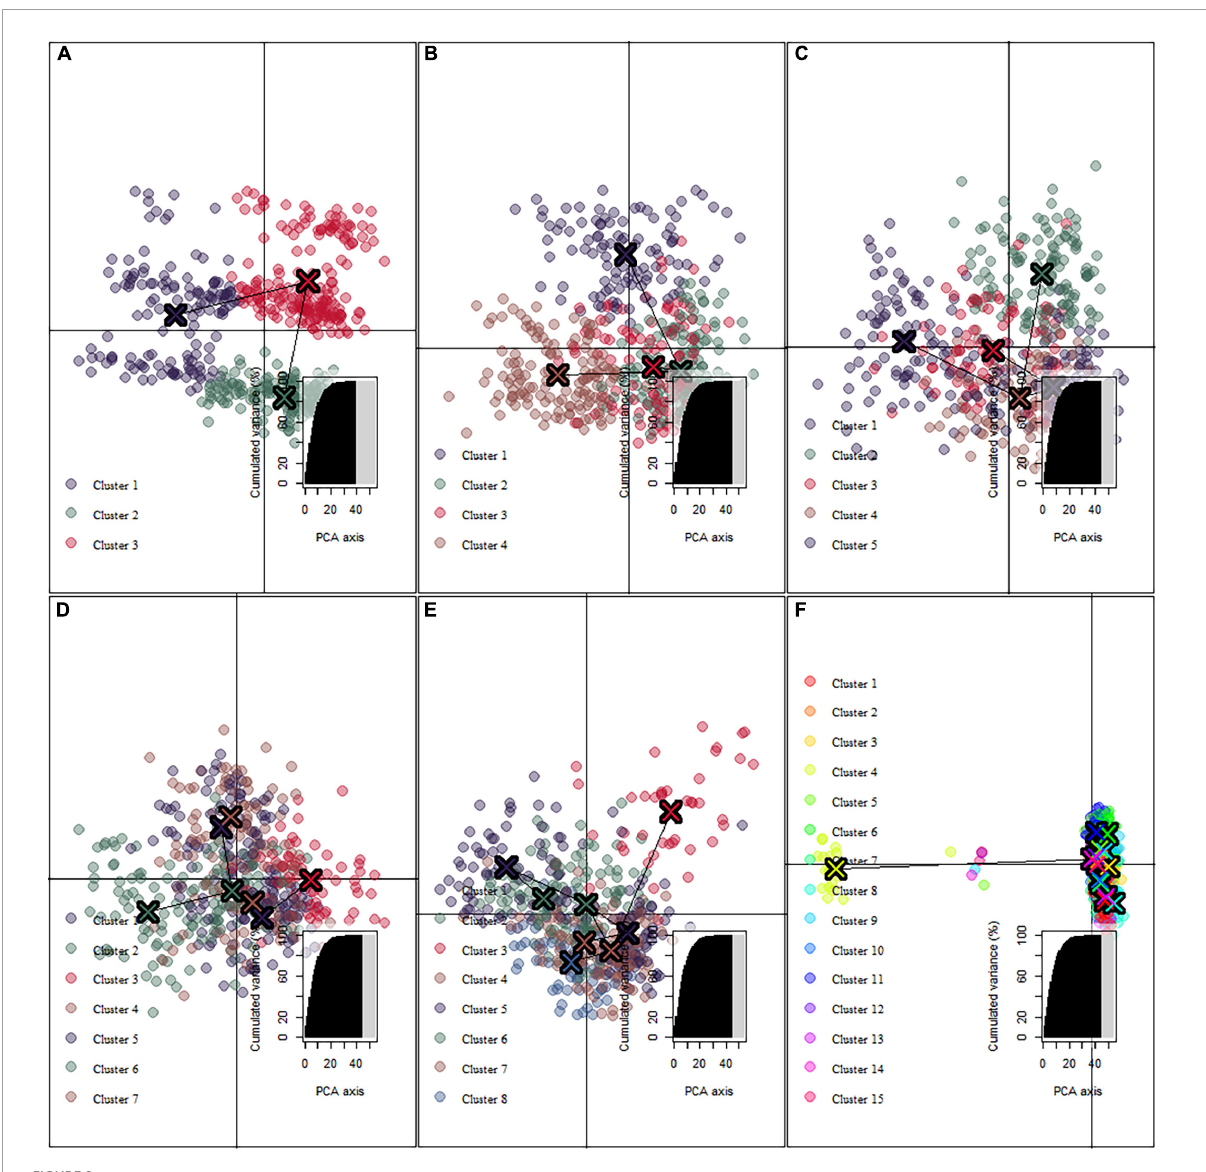
FIGURE2 Estimated population genetic cluster of S. empoasca populations. (A–F) DAPC cluster results at K = 3, 4, 5, 7, 8, and 15